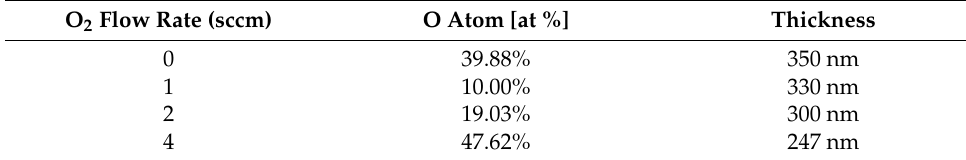
Figure 3. EDX spectroscopy analyses of the sample. Table 1. Oxygen content and thickness of samples.